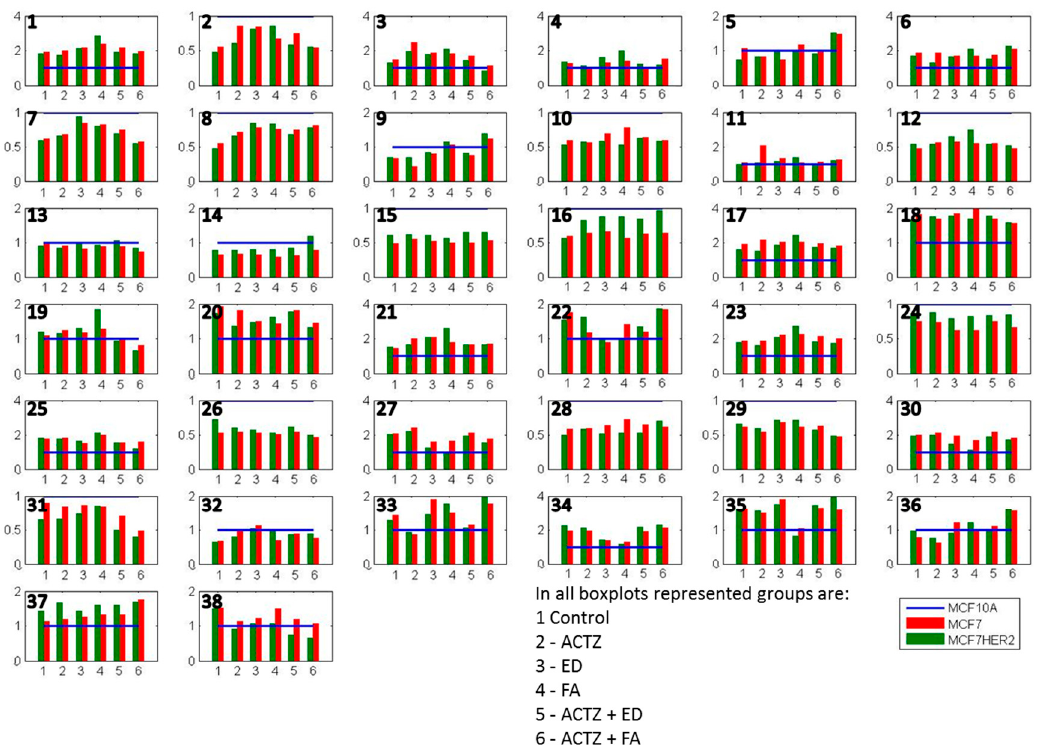
Figure 6. Average concentrations of metabolites in hydrophilic samples of three cell lines incubated in 6 different treatment conditions. All concentrations are shown relative to MCF10A concentrations that are represented by a normalized blue line with a value of 1. Shown metabolites are: 1 methylamine; 2 betaine; 3 malate; 4 lactic_acid; 5 lysine; 6 cisaconiticacid; 7 leucine; 8 valine; 9 isoleucine; 10 glutamate; 11 taurine; 12 glycine; 13 methionine; 14 glycerol-3-phosphate; 15 myoinositol; 16 serine; 17 oxoglutarate; 18 citricacid; 19 succinicacid; 20 glucose; 21 adenosine; 22 glycerophosphocholine; 23 tyrosine; 24 alanine; 25 glutamine; 26 creatine; 27 phosphocholine; 28 proline; 29 asparagine; 30 choline; 31 oxidized glutathione (GSSG); 32 tryptophan; 33 threonine; 34 histidine; 35 arginine; 36 ethanol; 37 acetate; 38 reduced glutathione (GSH). Values are the averages of 3 to 5 independent